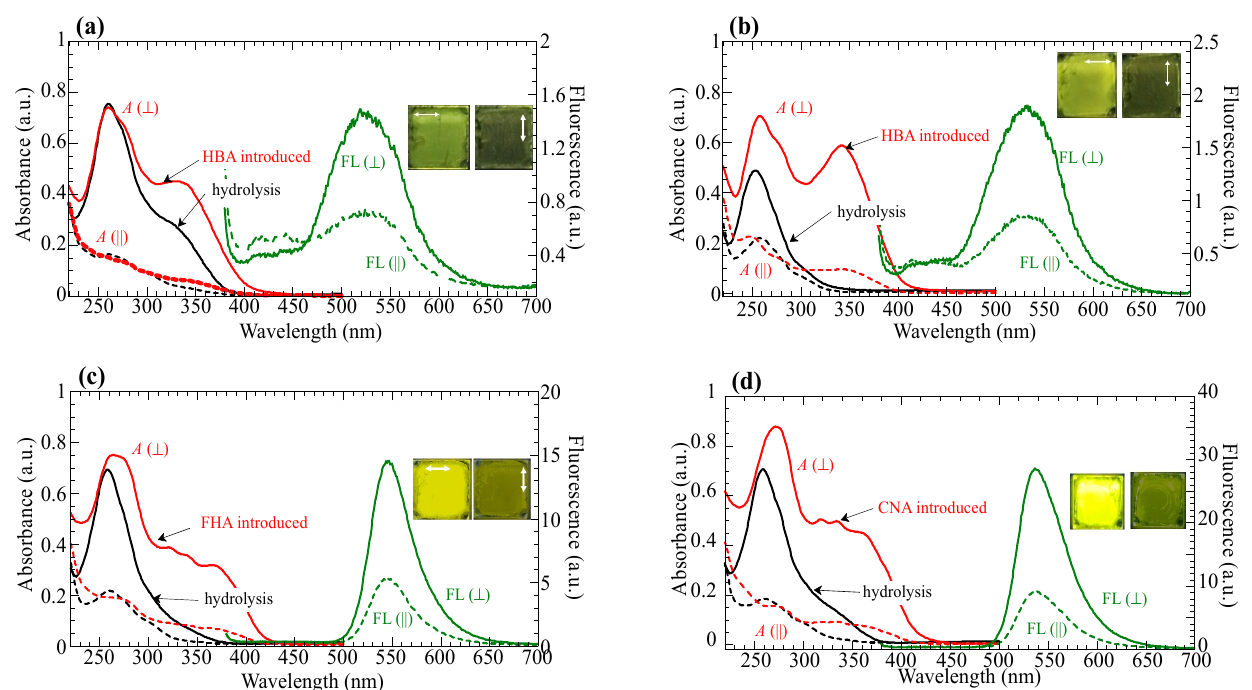
Figure 6. Changes in the polarized absorption spectrum of reoriented-hydrolyzed P4 films before and after the formation of N -salicylideneaniline derivative side groups using ( a , b ) HBA, ( c ) FHA, or ( d ) CNA and polarized fluorescence spectra of an N -salicylideneaniline-formed film. Insets show the chemical structure of the formed N -salicylideneaniline derivatives and photographs of the fluorescence via a polarizer. The DH values of the hydrolyzed films used are ( a ) 65%, ( b ) 94%, ( c ) 90%, and ( d ) 88%.